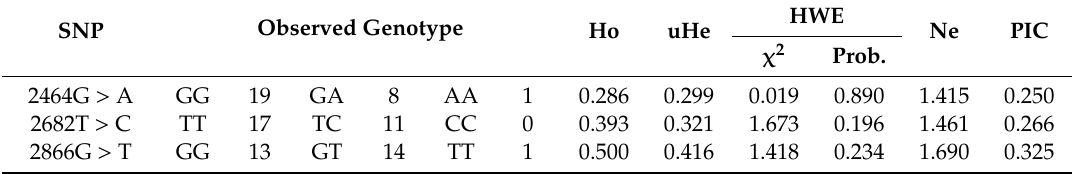
Table 1. Genotypic distribution and genetic diversity in 3 SNPs located on the PGR.